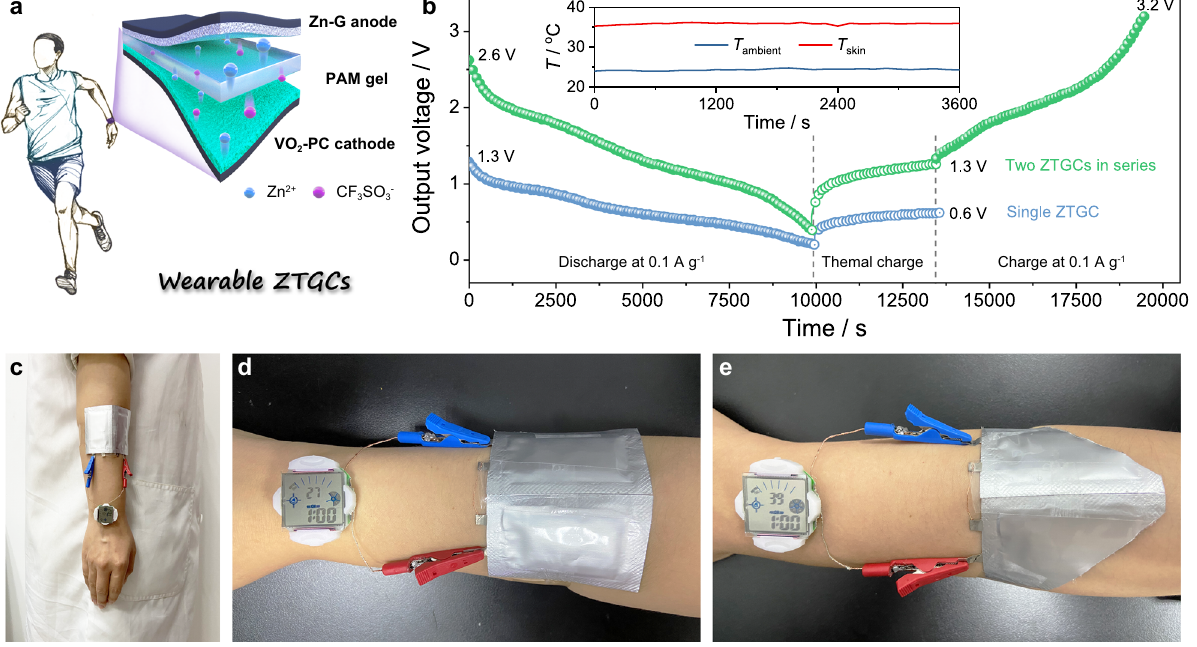
Fig. 6 Proof of concept of ZTCCs at various modes. a Schematic drawing of the wearable ZTCCs. b Charge/discharge process at galvanostatic and/or thermal models. The inset shows the change of body heat and ambient temperature. c – e A smartwatch powered by two ZTCCs in series at c , d initial state and e the harsh